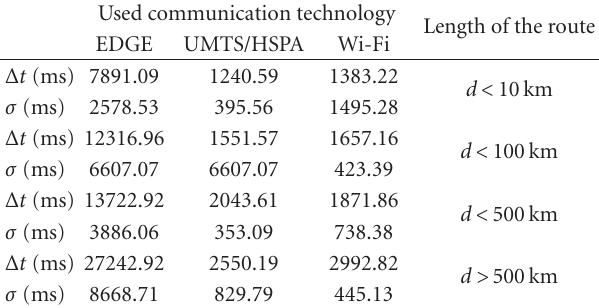
Length of the route